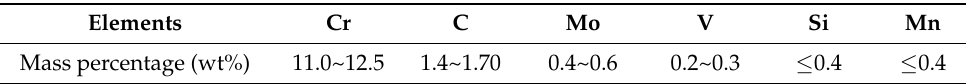
Table 1. Chemical composition of